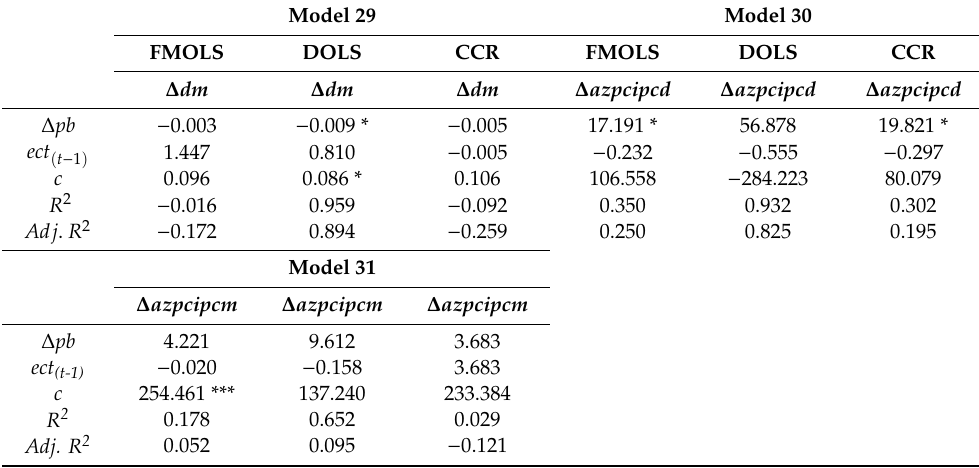
Table 15. The influence of oil price on macroeconomic indicators (Azerbaijan).